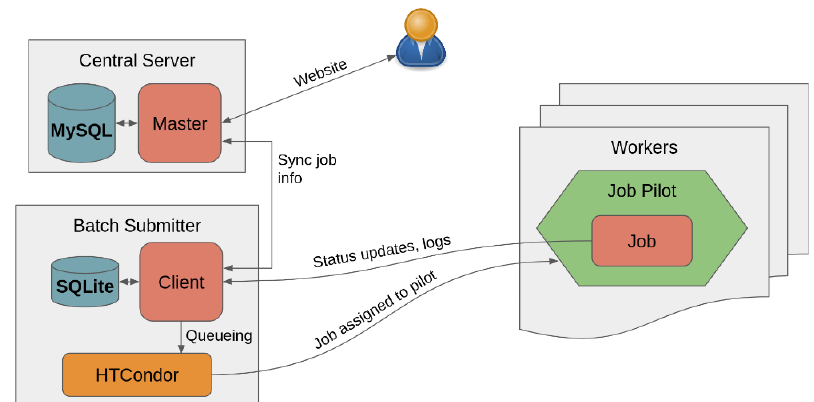
Fig. 1. A diagram of communications between different parts of IceProd, before the 2.4